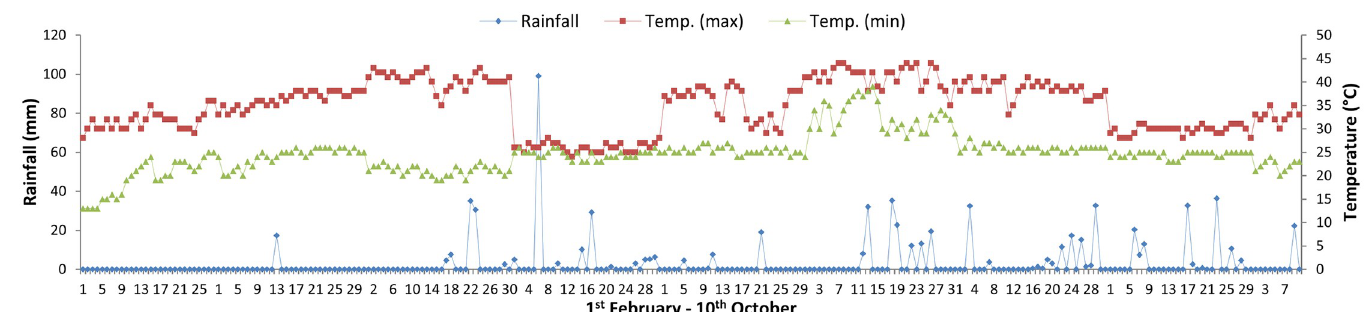
Fig 2. Daily rainfall, maximum and minimum temperatures in Madaya township, Myanmar during dry and wet seasons, 2017.